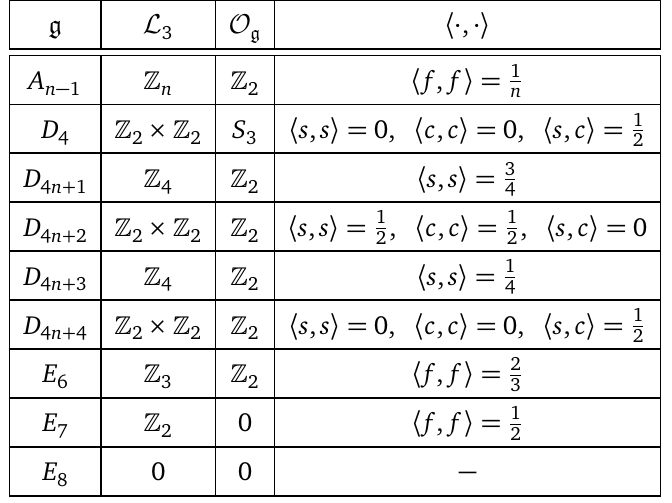
Table 1: Defect group L , its pairing 〈· , ·〉 and the 0-form group O for 6 d N = ( 2,0 ) g 3 theory of type g . Trivial groups are denoted by zero. We denote a generator of L for g = A , E , E as f ; a generator of L for g = D as s ; and generators of n − 1 6 7 3 2 n + 1 (cid:39) (cid:90) × (cid:90) L for g = D as s , c . S denotes the group formed by permutations of 3 2 2 2 n 3 three